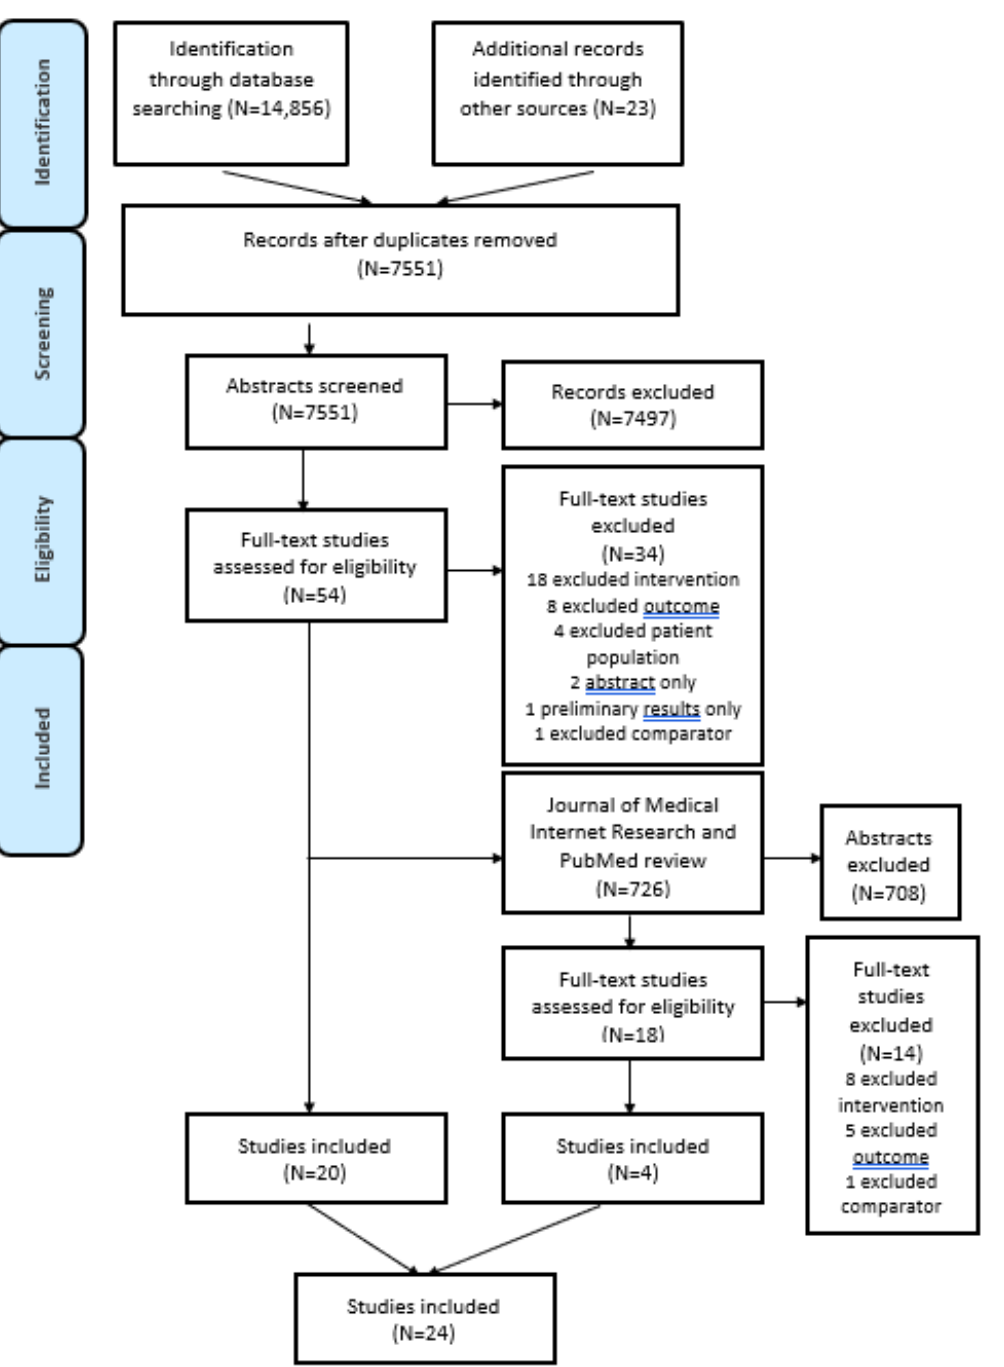
Figure 1. Preferred reporting items for systematic reviews and meta-analysis